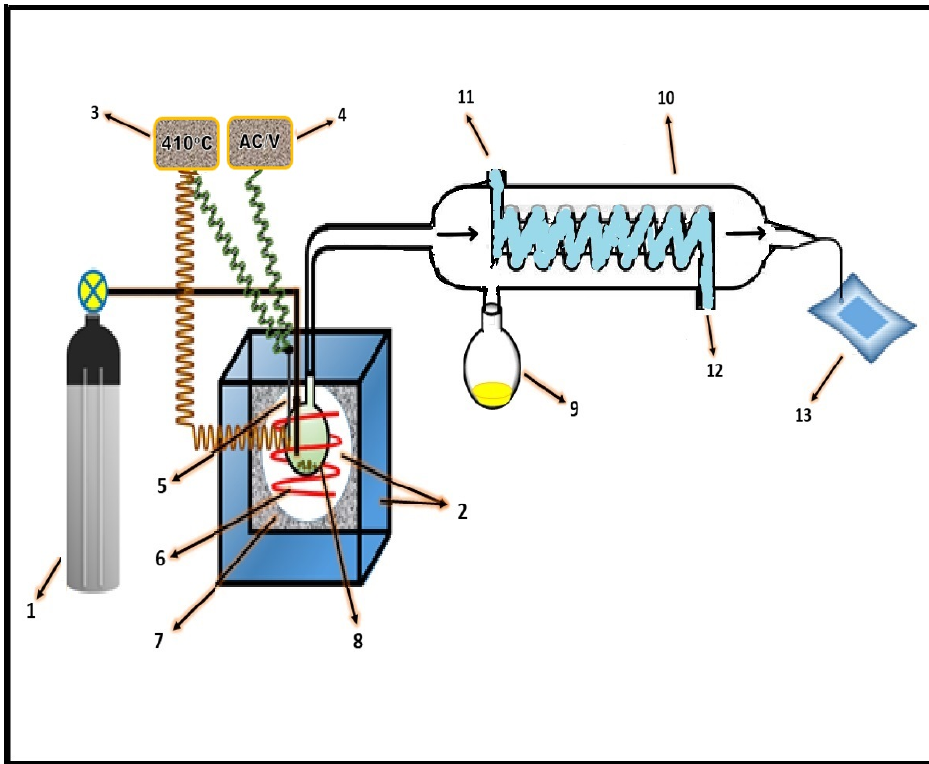
Figure 7. Experimental setup for pyrolysis: 1. nitrogen cylinder; 2. salt bath; 3. temperature controller; 4. power supply; 5. thermocouple; 6. coiled heater; 7. insulating material; 8. reaction vessel; 9. oil collection; 10. condenser; 11. water inflow; 12. water outflow; 13. gas-collecting bag.